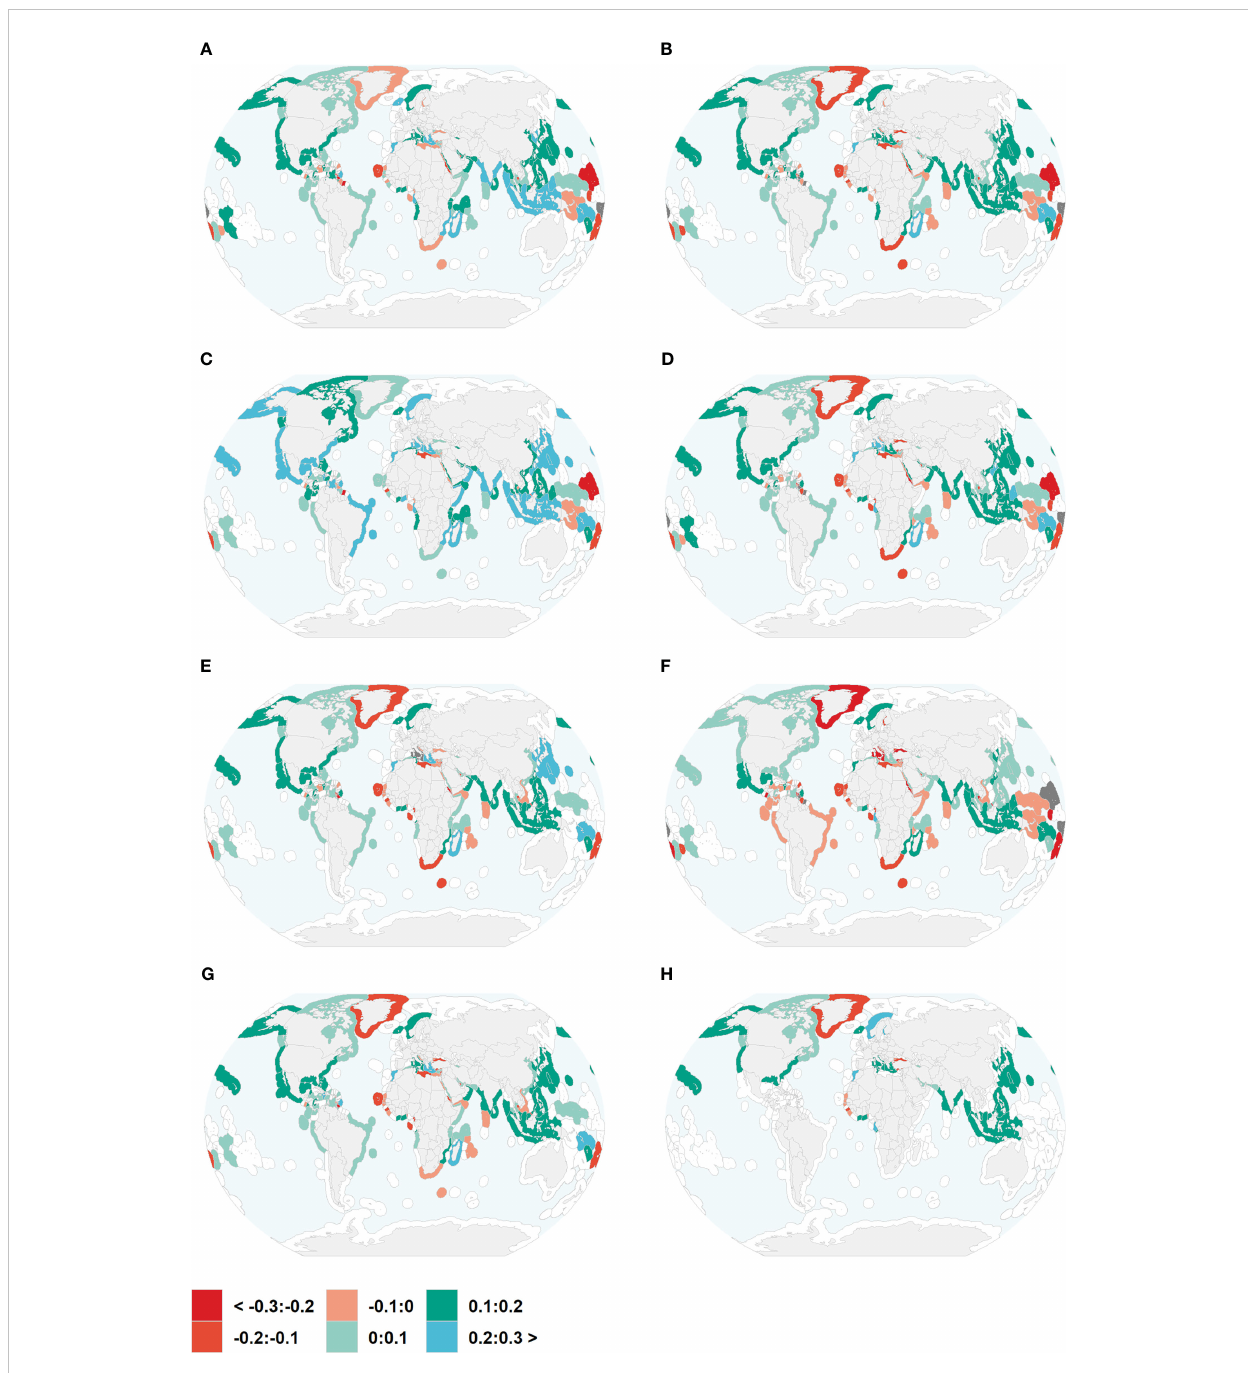
FIGURE 2 Country speci fi c elasticities. Global maps providing the country-level marginal effect elasticities (a 1% change) calculated on the continuous predictor variables including: (A) fuel price, (B) SST, (C) crustaceans, (D) large pelagic, (E) mixed pelagic, (F) marine fi shes, (G) molluscs, and (H) diadromous fi shes. Colors represent percentage change in technical ef fi